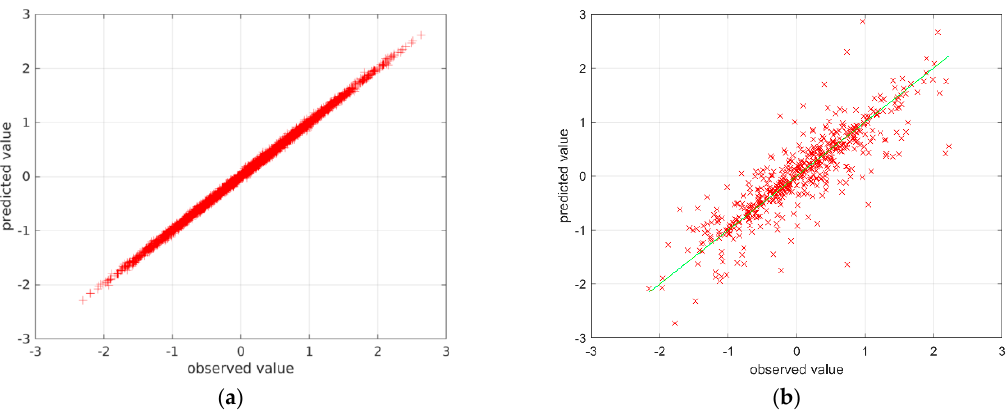
Figure 3. The samples against the estimated values.